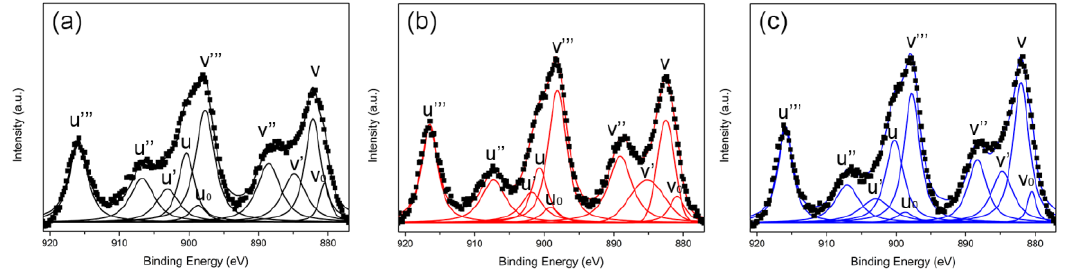
Figure 6. Ce 3d XPS spectra of ( a ) Ru/CeO 2 -NRs, ( b ) Ru/CeO 2 -NCs, and ( c ) Ru/CeO 2 -NPs.